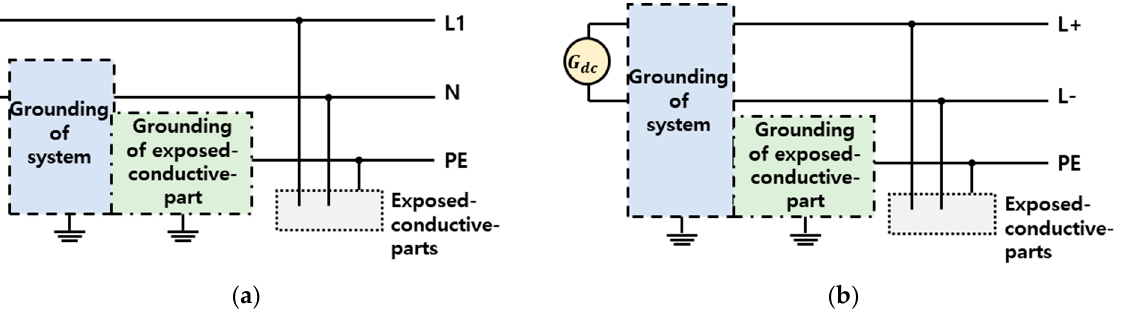
Figure 2. Comparison of the system configurations between AC and DC based on the grounding of the system and exposed conductive part: ( a ) AC system; ( b ) DC system.